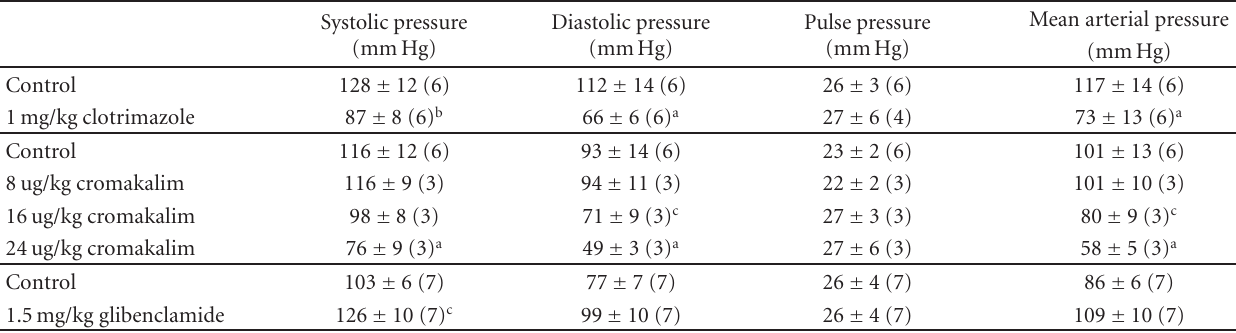
Table 1: The pressor and depressor e ff ects of clotrimazole (1mg/kg i.v.), glibenclamide (1.5mg/kg i.v.), and cromakalim (8–24ug/kg i.v.) on the systolic, diastolic, pulse, and mean arterial blood pressure in the anaesthetised rat. Blood pressures are expressed as mmHg tension. Results are expressed as means ± standard error of the mean with the number of observations in parenthesis or as di ff erences in the means before and after intravenous drug administration. Statistical significance ( a P < . 001; b P < . 02; c P < . 05) for comparison of parameters prior to and after drug administration.